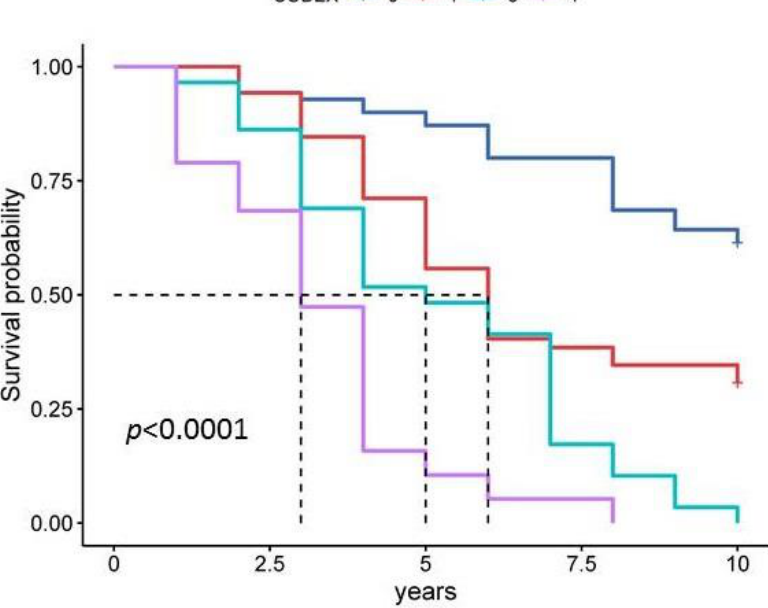
Figure 7. Kaplan–Meier curve plot for the CODEX index in estimating 10-year survival. Note: Quartile 1 is a score of 0 to 2, quartile 2 is a score of 3 to 4, quartile 3 is a score of 5 to 6 and quartile 4 is a score of 7 to 10.